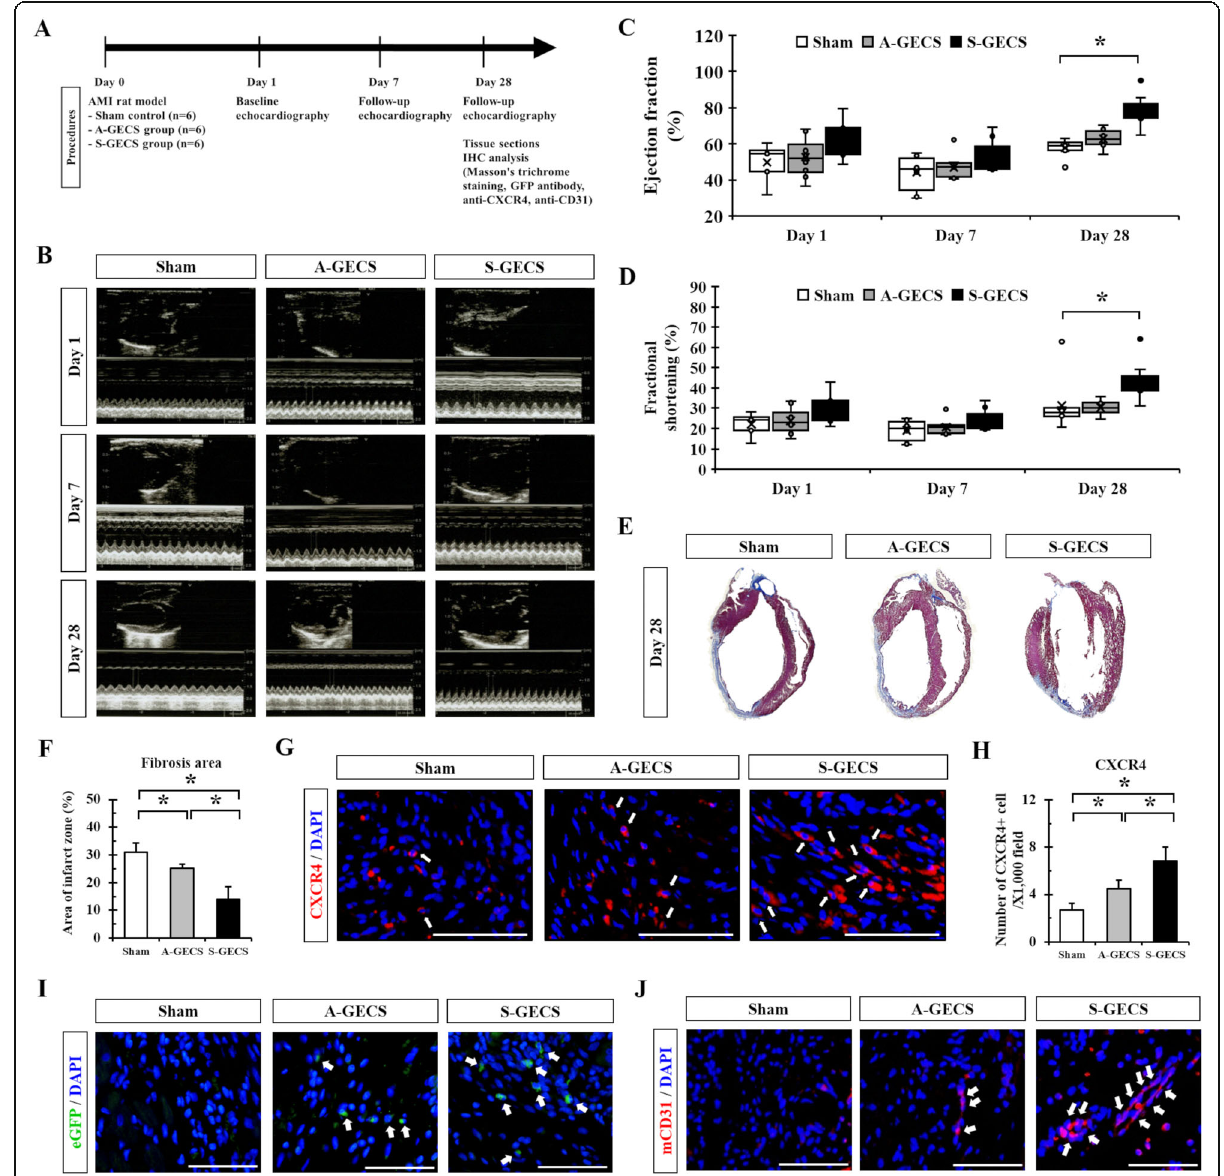
Fig. 4 S-GECS transplantation into infarcted myocardium and cardiac regeneration. a Schematic diagram of S-GECS transplantation into